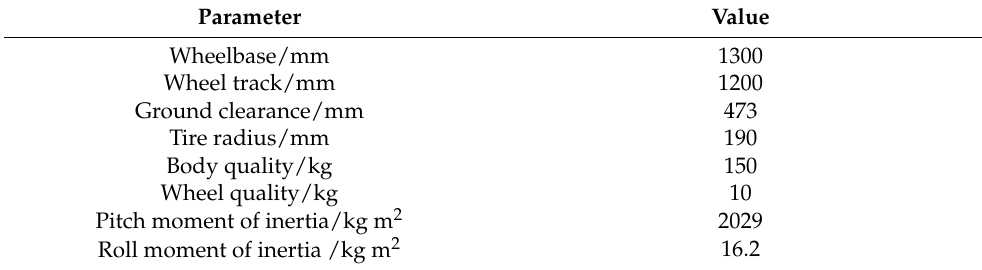
Table 1. Parameters of the